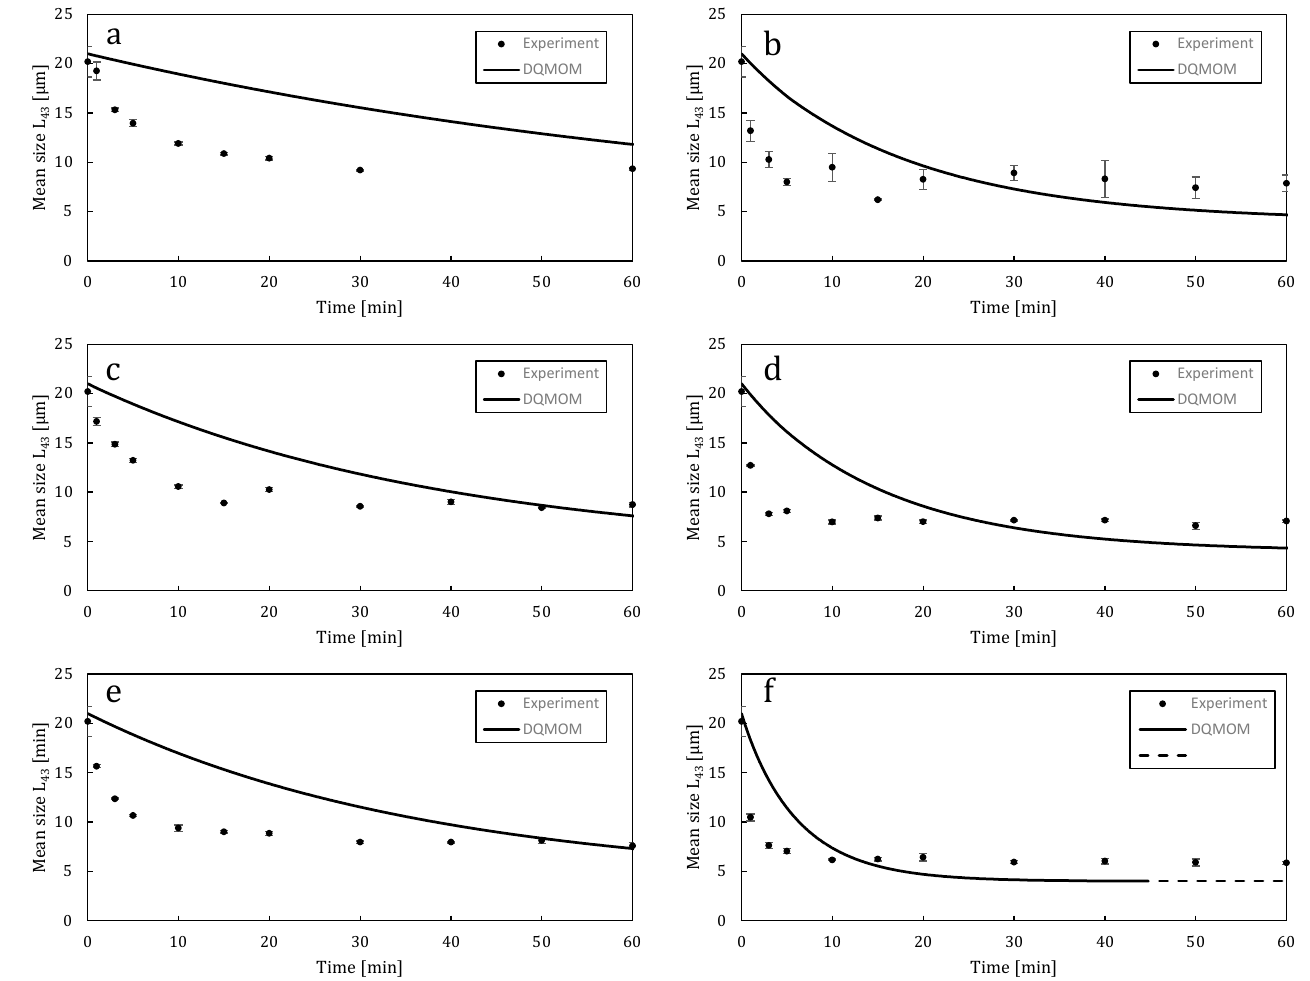
Figure 9. Comparison of experiments and population balance results. ( a ) Impeller 1, 1200 rpm; ( b ) impeller 1, 3000 rpm; ( c ) impeller 2, 1200 rpm; ( d ) impeller 2, 3000 rpm; ( e ) impeller 3, 1200 rpm; ( f ) impeller 3, 3000 rpm.